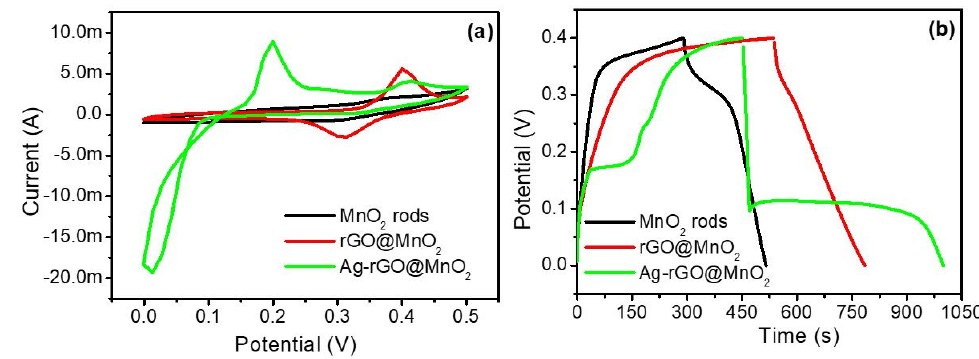
Figure 10. Comparative ( a ) CV curve of pure MnO 2 rods, rGO@MnO 2 , and Ag-rGO@MnO 2 at fixed scan rate 10mV/s within potential window 0.0–0.5 V and ( b ) GCD curve at fixed current density 0.5 Ag − 1 with potential difference 0.0–0.4 V. Table 3. The comparative specific capacitance of pure MnO 2 and its composites with the prepared electrode based on Ag-rGO@MnO 2 nanocomposite in previously published papers.